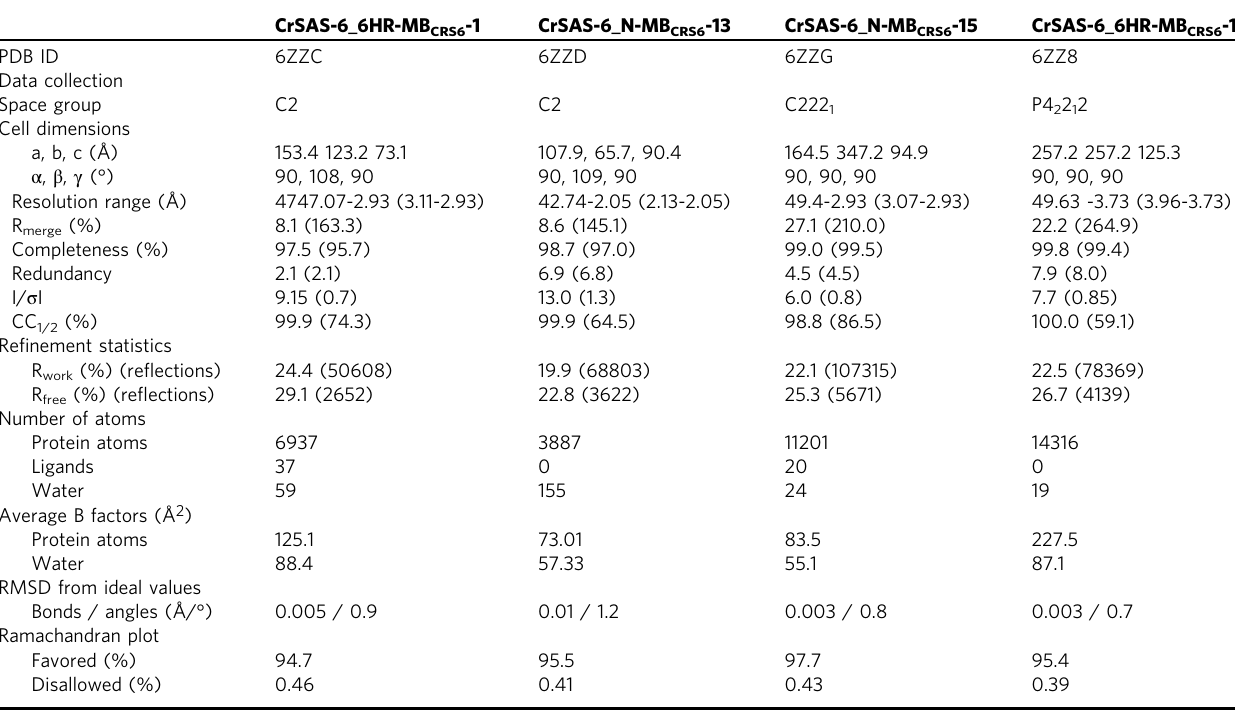
Table 1 Data collection and re fi nement